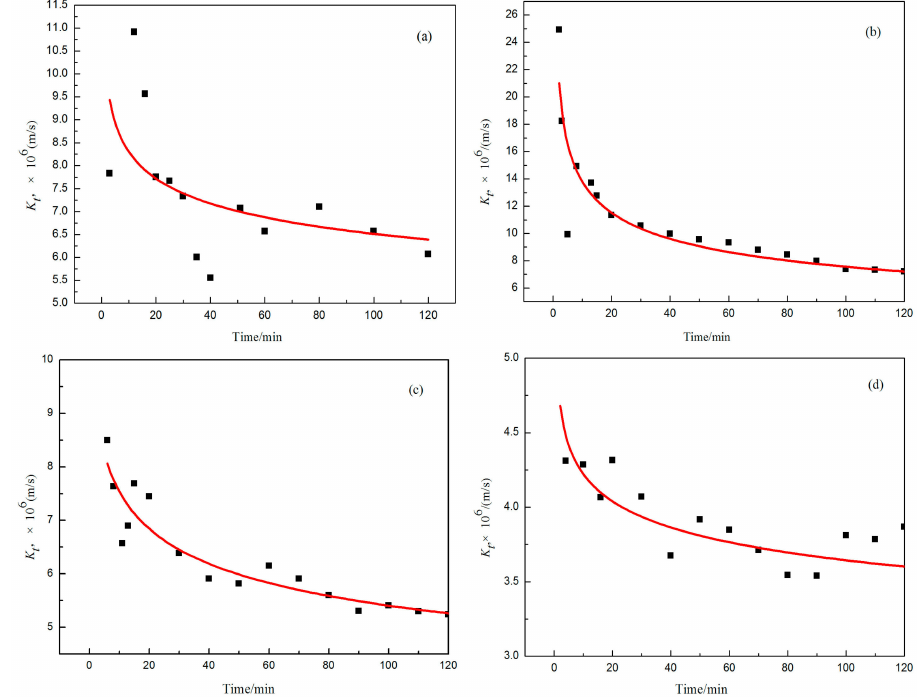
Figure 3. The relationship between k t and t of di ff erent cokes. ( a ) Coke 1 ( R = 96.22%, m ci = 7.5 g),